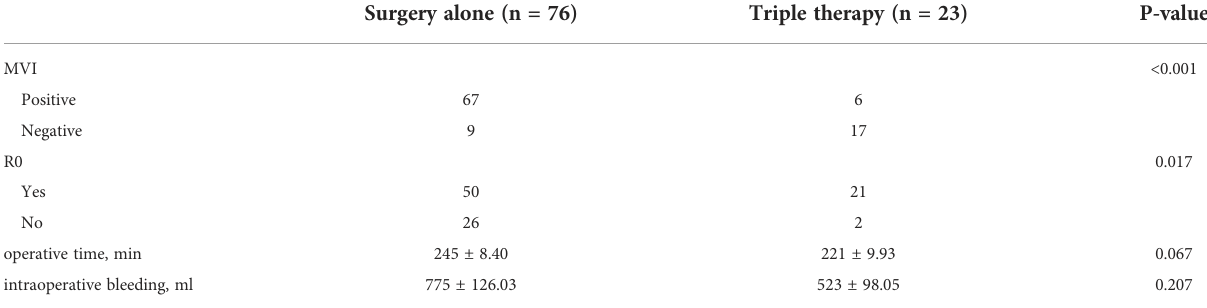
TABLE 2 Postoperative and intraoperative clinicopathological features.